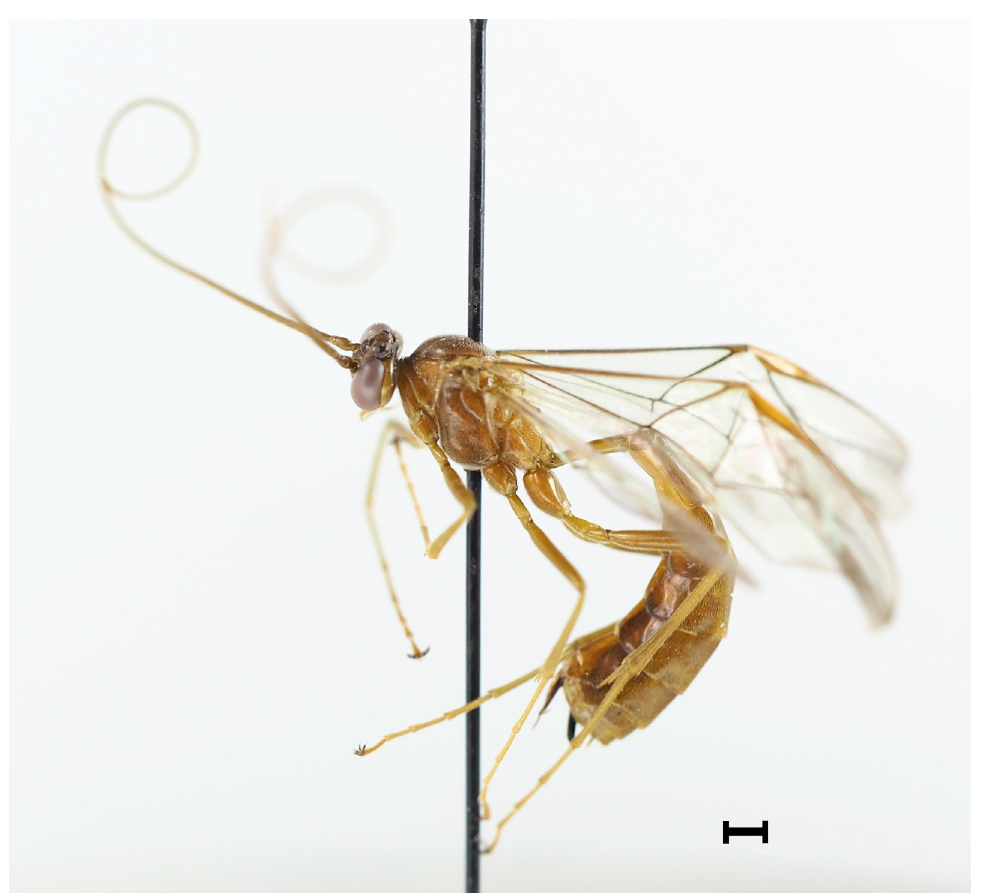
Fig. 28. Ophion brocki Johansson sp. nov., paratype, ♀ (NHRS-HEVA000008633). Scale bar = 1